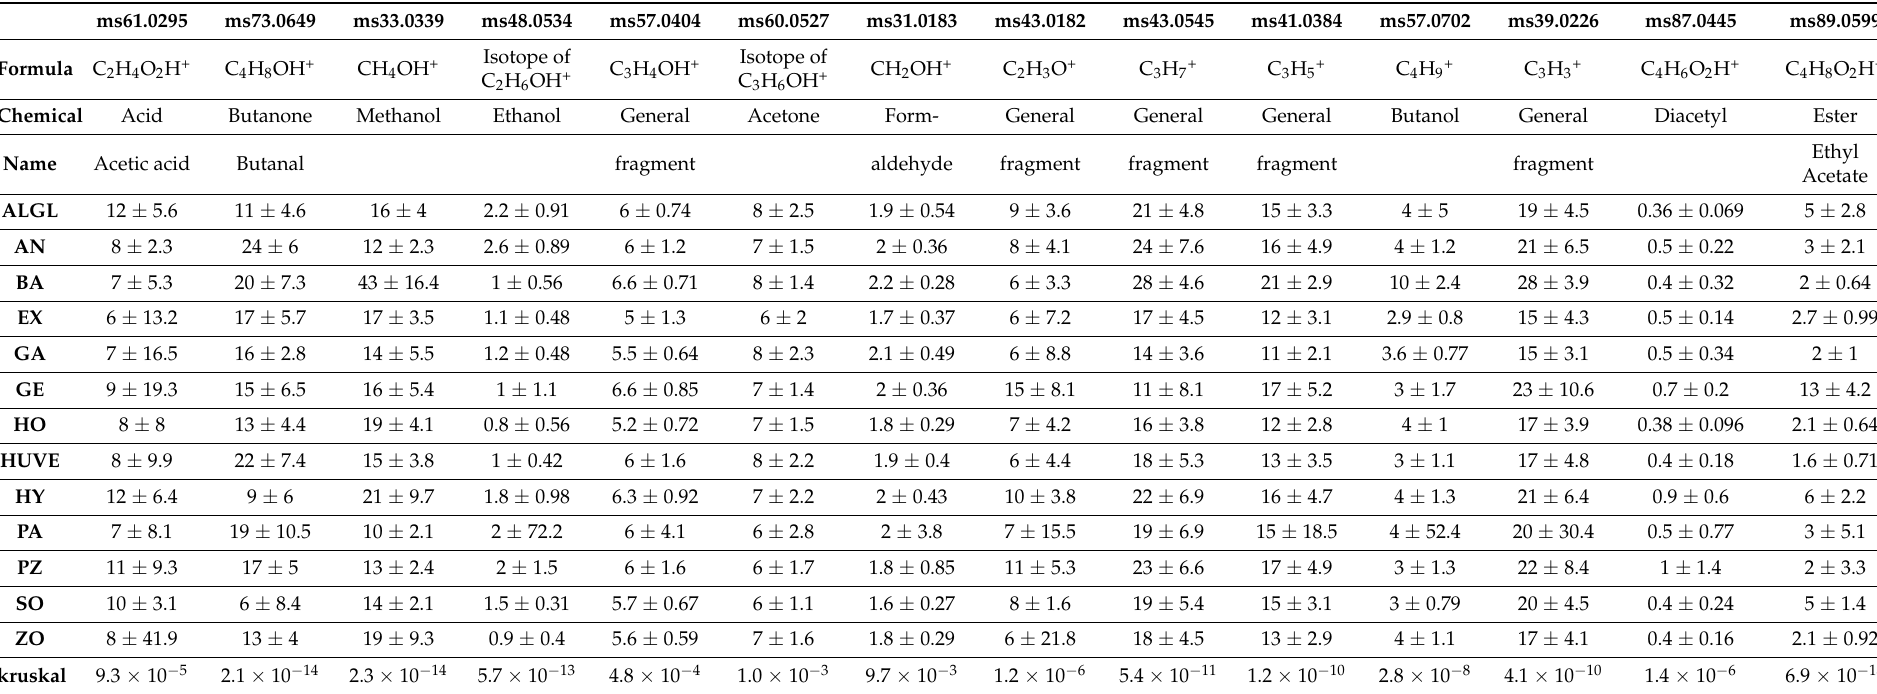
Table 3. Mass peaks with generally high relative concentrations in Mortierella s. l. species. Values illustrate median and standard deviation of concentrations in [ppbV] across all technical replications of all biological representatives. The row “kruskal” indicates that the peak concentrations differ significantly between species (kruskal p -value). ALGL = M. alpina/globalpina , AN = M. angusta , BA = M. bainieri , EX = L. exigua , GA = L. gamsii , GE = M. gemmifera , HO = P. horticola , HUVE = P. humilis/verticillata , HY = P. hyalina , PA = E. parvispora , PZ =